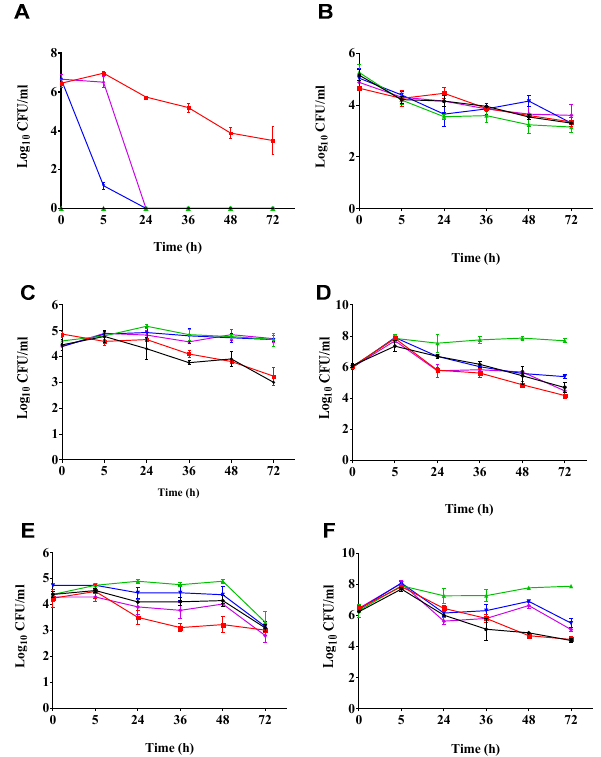
Figure 2. Impact of phage treatment on C. difficile and other components of the gut microbiota. The impact of phage treatment was ascertained by recovering the bacteria on selective media for ( A ) C. difficile ; ( B ) bifidobacteria; ( C ) enterococci; ( D ) enterobacteria; ( E ) lactobacilli; ( F ) total anaerobes . The bacterial counts of the different treatment vessels and time points are presented. Black lines, vessel 1, untreated slurries; red lines, vessel 2, C. difficile control; green lines, vessel 3, phage-only-treated control; blue lines, vessel 4, prophylaxis regimen, and purple lines, vessel 5, remedial regimen. The data was analysed using GraphPad Prism 7. Error bars are SEMs of 3 biological replicates.